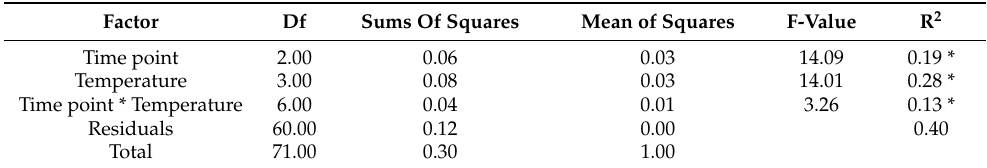
Table 5. Effects of temperature and time on the metabolites in Hapalosiphon sp. (MRB 220))— PerMANOVA. Factor Df Sums Of Squares Mean of Squares